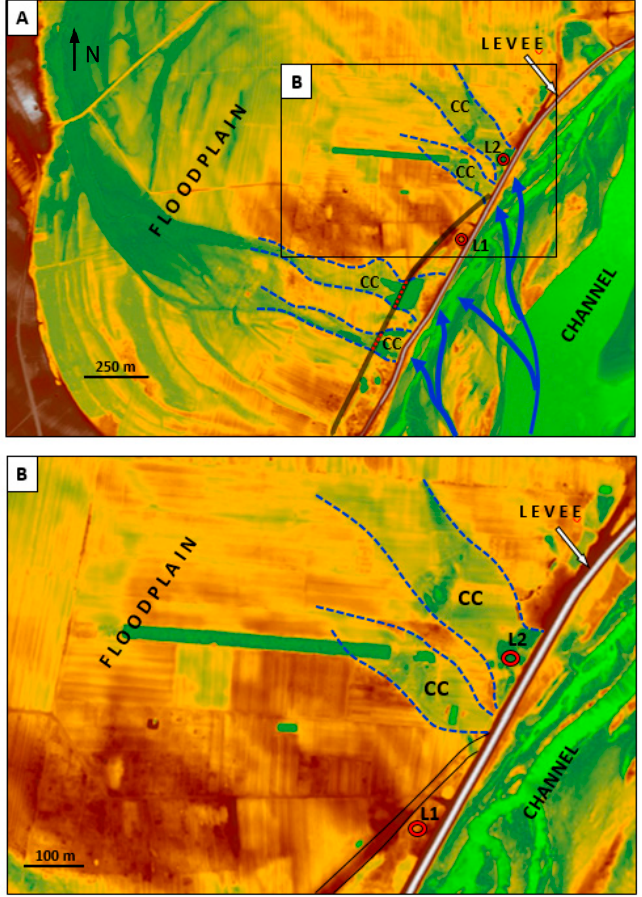
Figure 6. Location of measurement points against the background of the dynamic digital elevation model, CC—crevasse channel; L1, L2—data loggers; color scale: dynamic DEM is automatically adjusted to the height range (the highest areas are marked with white and red, and the lowest areas with light green).